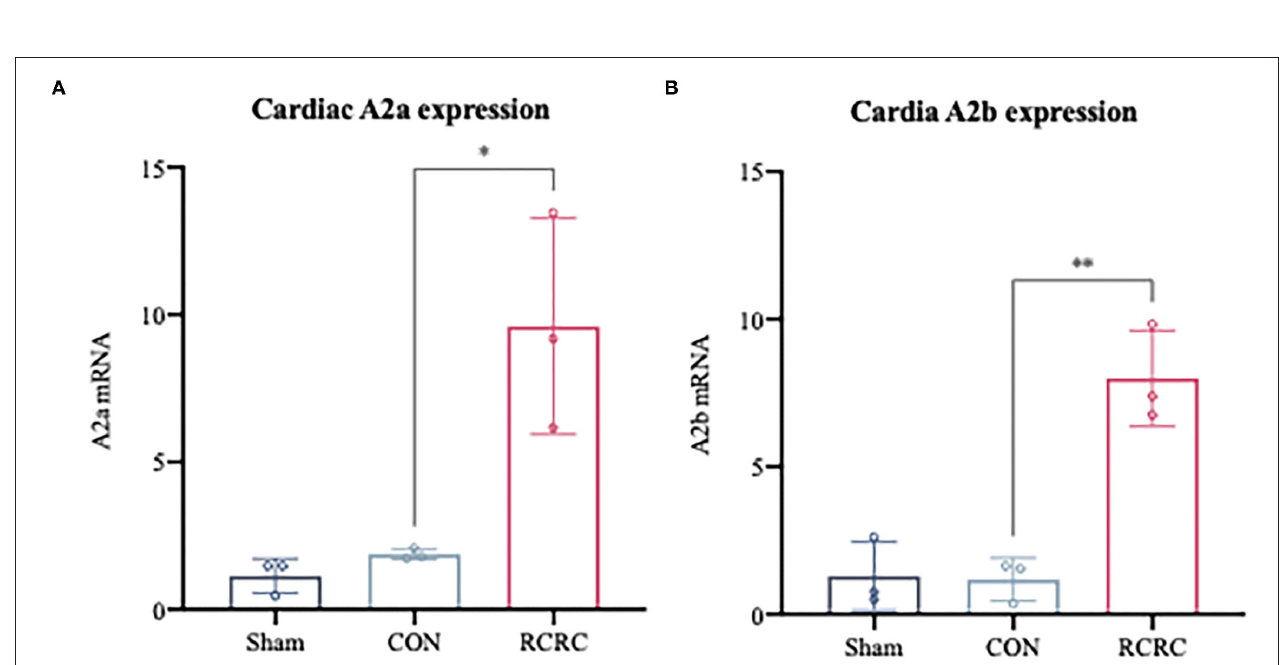
FIGURE 4 | A2 adenosine receptors mRNA expression in infarct myocardium after treatment with 3 days of remote conditioning. (A) Relative A2a AR mRNA levels were determined by RT-PCR after treatment with 3 days of remote conditioning, N = 3. (B) Relative A2b AR mRNA levels were determined by RT-PCR after treatment with 3 days of remote conditioning. All values represent as means ± SD. N = 3. * p < 0.05, ** p < 0.01 vs. CON.